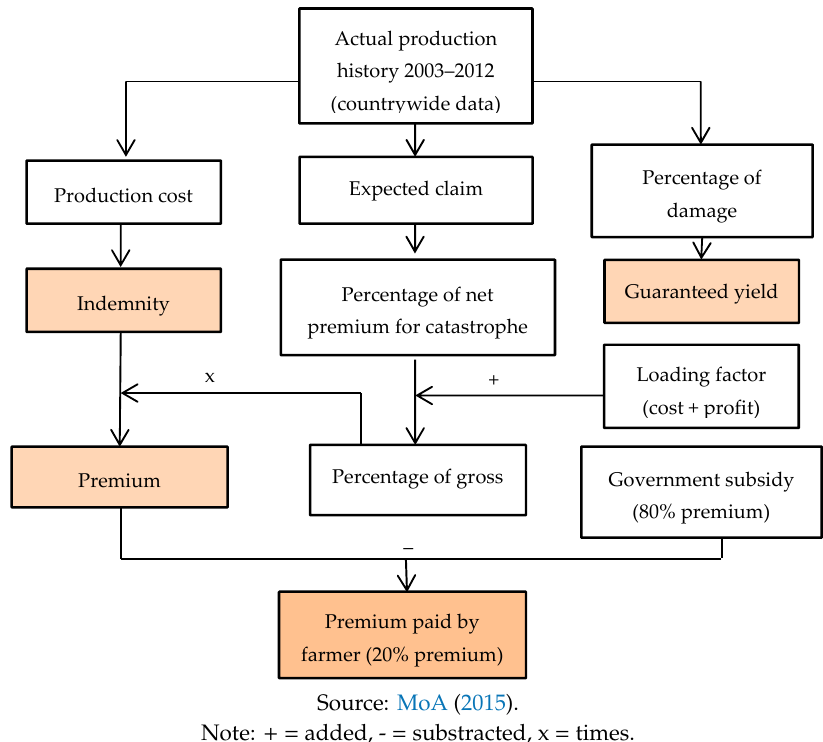
Figure 1. Indemnity, guaranteed yield, and premium determination.